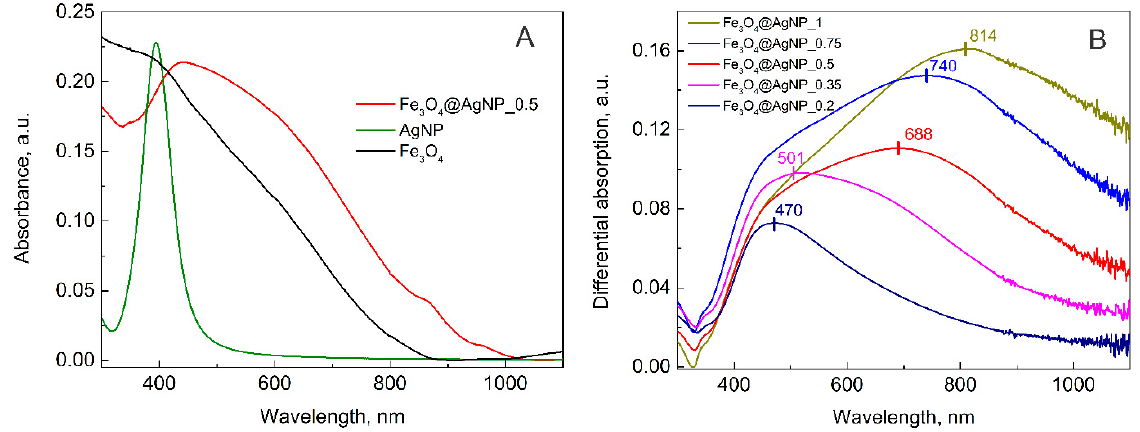
Figure 2. ( A ) Absorption spectrum of magnetite NPs (black), silver NPs (green), and magnetite NPs decorated with silver NPs (Fe 3 O 4 @AgNP_0.5; red); ( B ) the differential spectra of various amounts of AgNP-decorated magnetite, calculated by subtracting magnetite absorption spectra from each sample with decorated NPs.